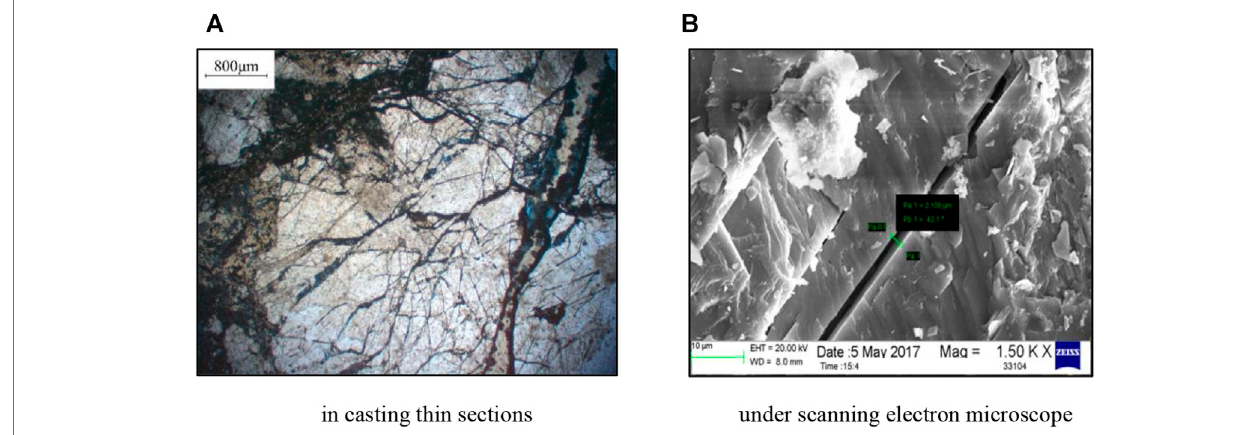
FIGURE 1 | Demonstrations of microfracture distribution. (A) In casting a thin sections, (B) Under a scanning electron microscope.